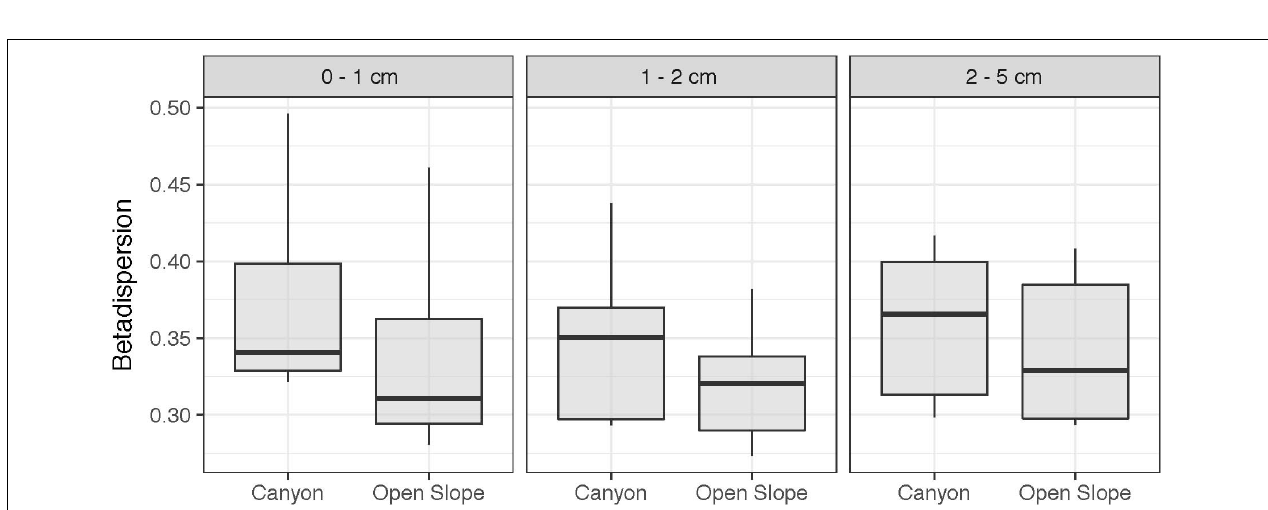
FIGURE 7 | Beta-diversity (as Betadispersion) of samples (with both Archaea and Bacteria) grouped by habitat and sediment layer.